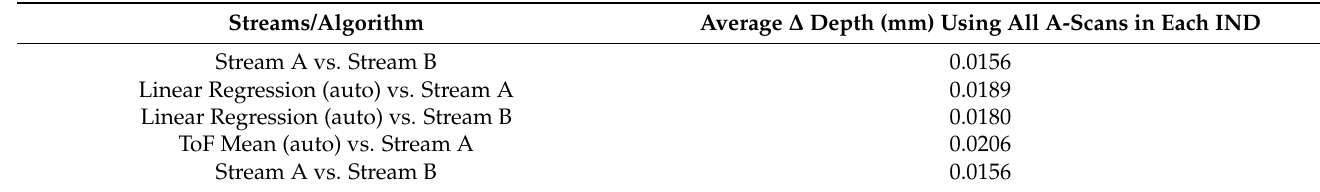
Table 1. Auto depth measurement relative accuracy based on all A-scans in each IND.